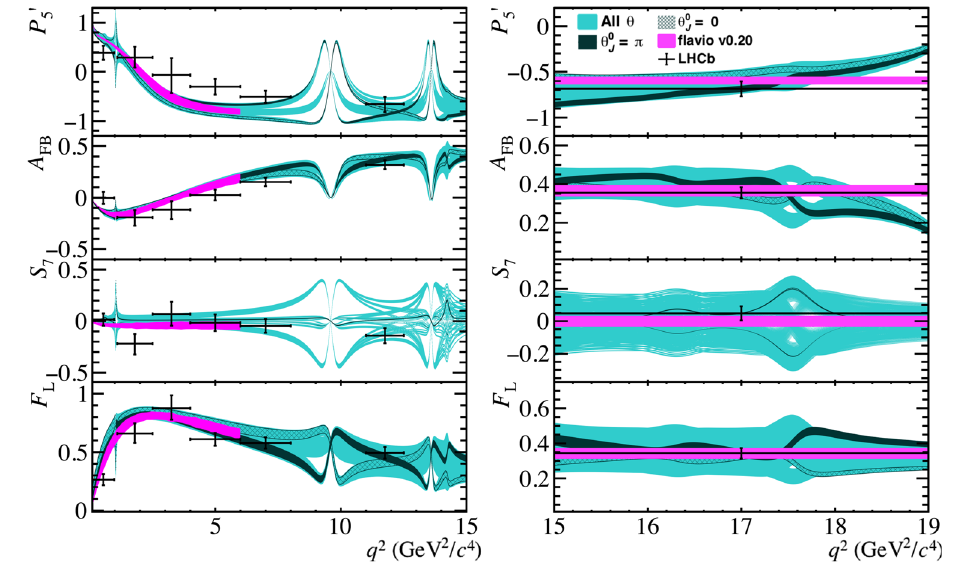
Fig. 3 Distributions of the angular observables P (cid:10) observables from Ref. [49] are also shown (black points). The theo- , A FB S 7 , and F L 5 retical predictions (magenta band) using flavio [48] are shown for as a function of q 2 for regions below (left) and above (right) the open = 0 charm threshold (cyan). Specific choices are highlighted for θ 0 j = π (dark band). The measured values of the (hatched band) and θ 0 j